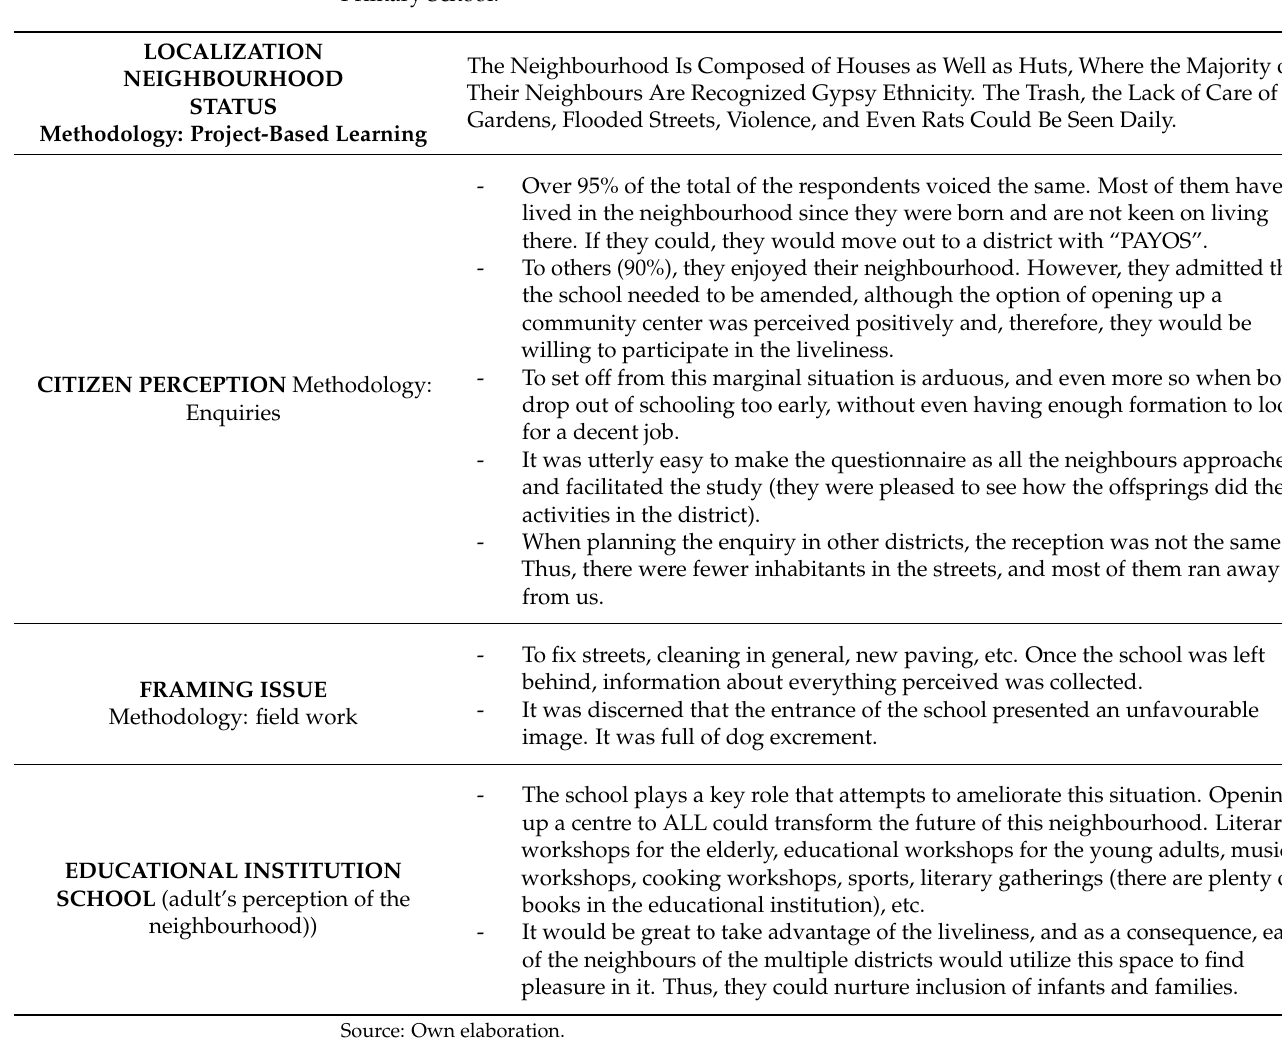
Table 4. Diagnosis of the students’ work “Everyone’s Responsibility: Pet Spreading” by Pio XII Primary School.